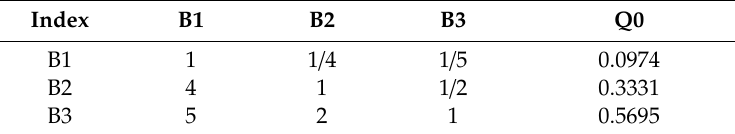
Table 2. Subjective weight of the rule hierarchy.